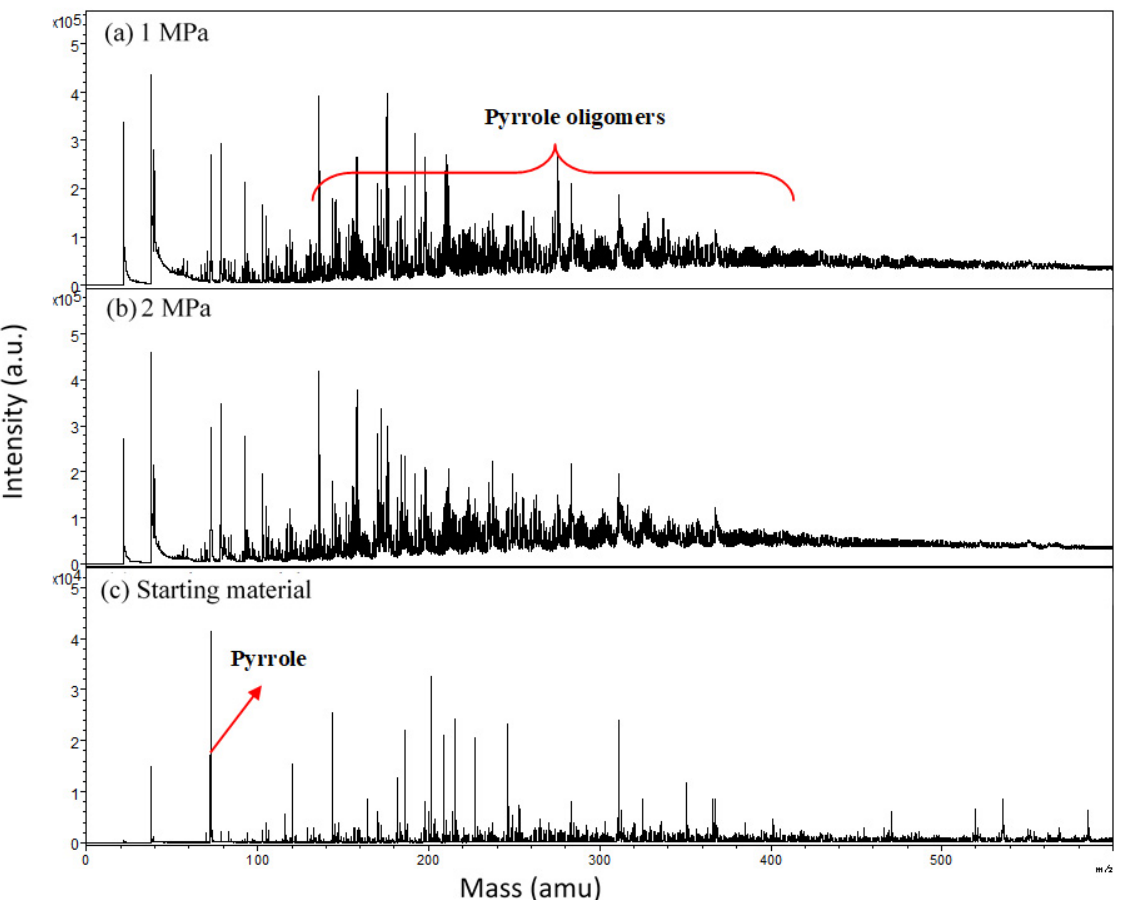
Figure 6. MALDI-TOF mass spectra of pyrrole after treatment using pulsed discharge plasma [37].